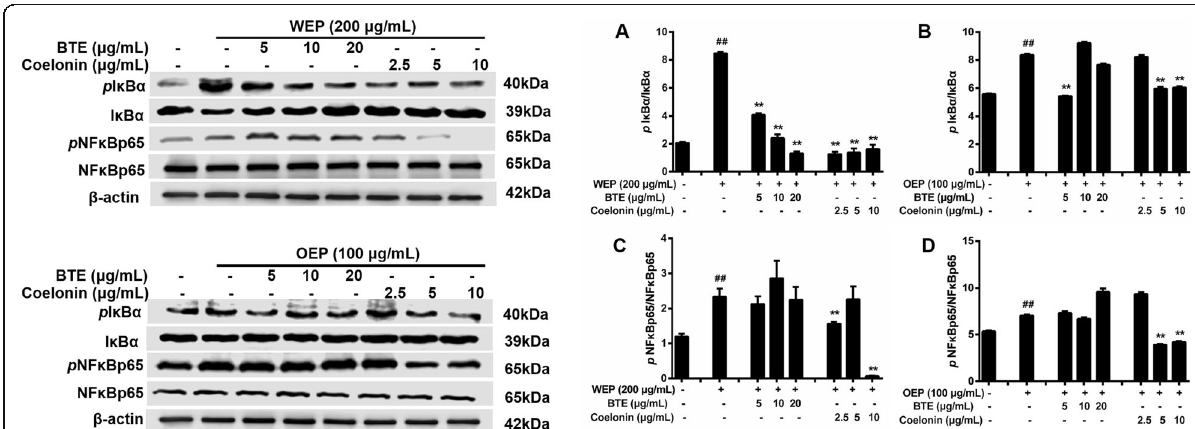
Fig. 7 EFB pretreatment inhibited PM 2.5 extracts evoked activation of NF- κ B pathway in RAW264.7 cells. Protein synthesis in RAW264.7 cells exposed to 200 μ g/mL WEP or 100 μ g/mL OEP, which was attenuated by BTE and Coelonin. # < 0.05, ## < 0.01 vs. control. * < 0.05, ** < 0.01 vs. model (PM 2.5 extract-only